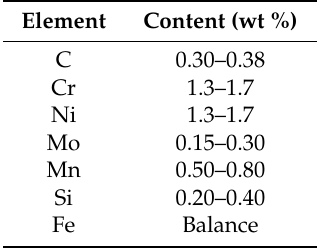
Table 2. Processing parameters of laser forming repair for 34CrNiMo6